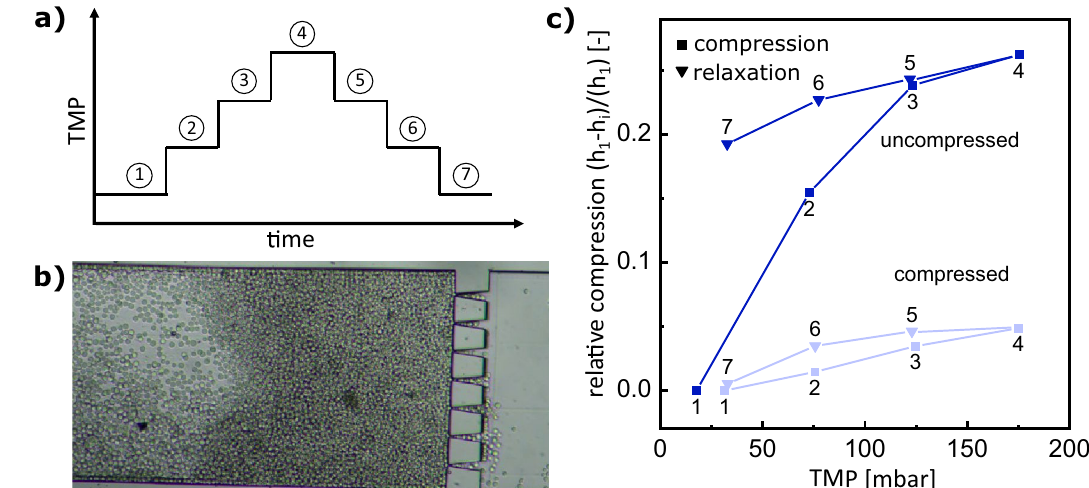
Figure 2. Cake thickness during pressure stepping experiment. Experimental procedure of the applied transmembrane pressure (TMP) steps ( a ). Light microscopy image of the microfluidic membrane channel and the filter cake during pressure step 1 ( b ). Cake compression relative to the initial thickness uncompressed and a previously compressed filter cake during pressure stepping experiments ( c